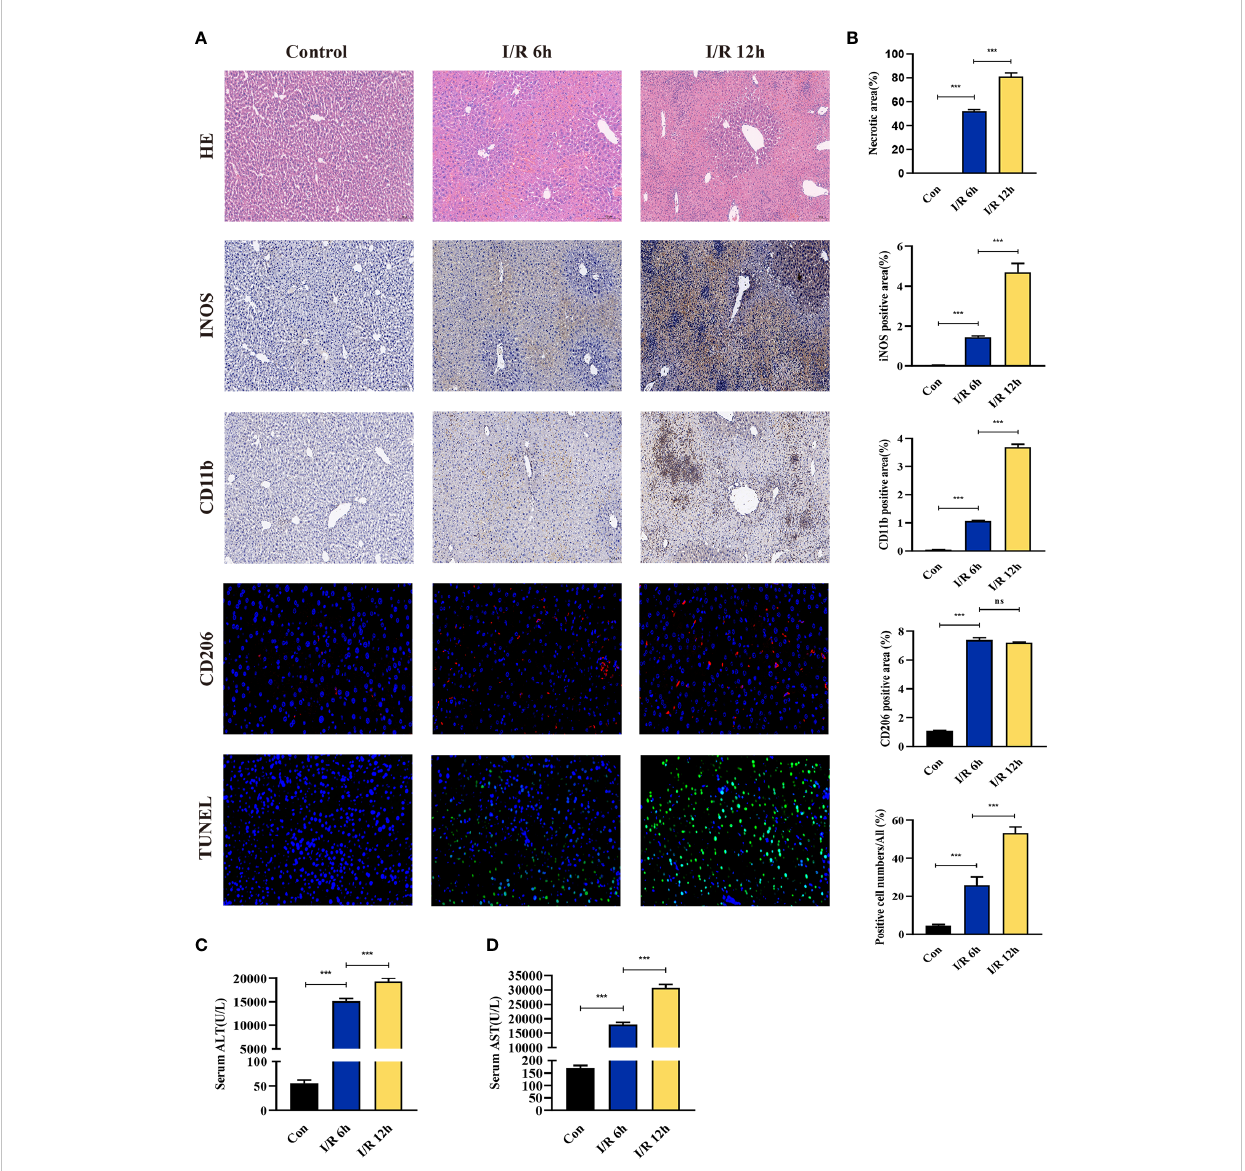
FIGURE 9 Evaluation of liver injury, hepatocyte apoptosis, and immune cell in fi ltration in a hepatic ischemia-reperfusion induced injury mouse model. (A) Representative pictures of HE staining, immunohistochemical staining, immuno fl uorescence staining, and TUNEL staining (magni fi cation, 40x). (B) Quanti fi cation of liver injury score, immune cell-related molecules in the INOS, CD11b, and CD206 positive areas, and apoptosis of liver cells. (C, D) Serum ALT/AST activity at different reperfusion times after hepatic ischemia. ***p < 0.0001. ns=non-signi fi